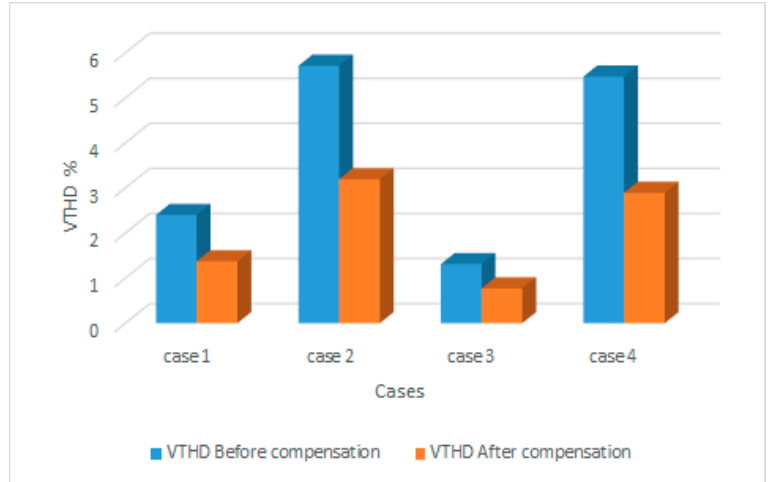
Figure 7. Improvement shown by reduction of the voltage harmonic distortion levels ( VTHD ) below